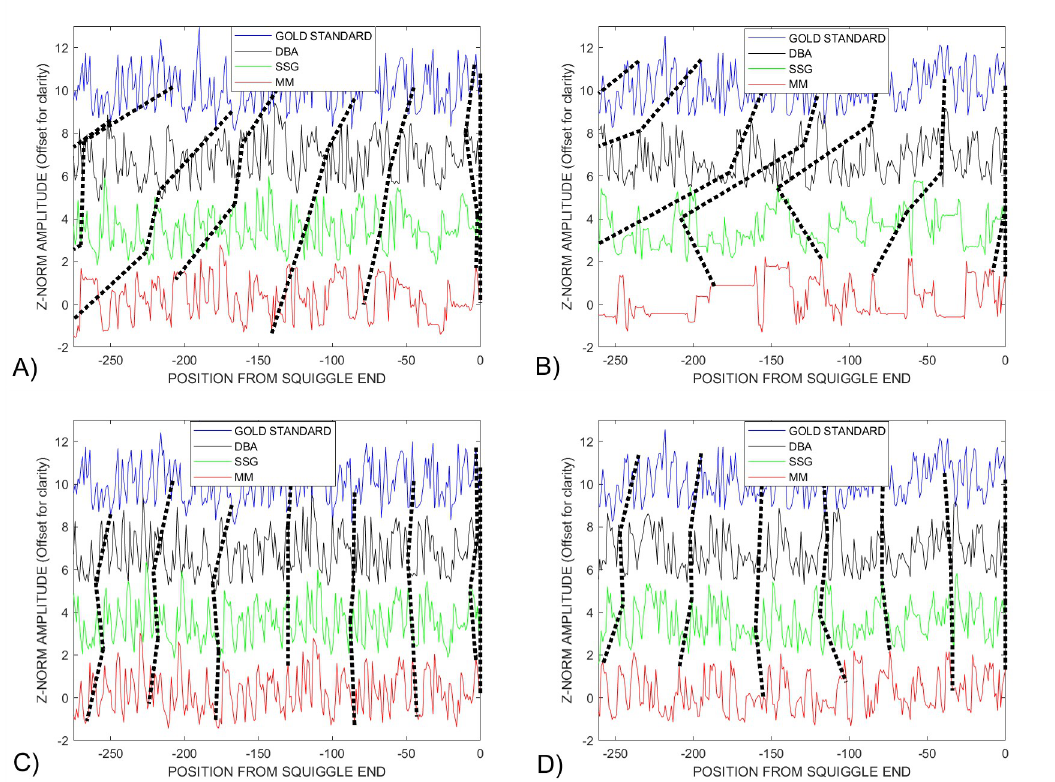
Fig 14. The original, unwarped SSG , green, MM , red, and DBA , black consensus signals for the A) Sequin R1-71-1 and B) R2-55-3 studies show significantly more distortions, non-vertical dashed lines between equivalent warp points, than were present in the Enolase study, Fig 9A. After voting, the consensus signals within the C) R1-71-1 and D) R2-55-3 studies become more equivalent to each other as shown by the more vertical dashed lines connecting equivalent warp positions within the unwarped